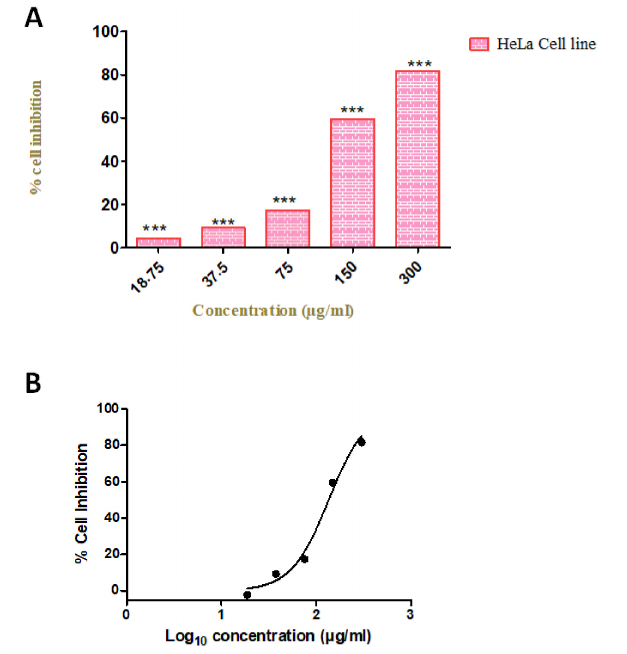
Figure 7. Cellular metabolic activity indicated by cell viability. ( A ) Cytotoxicity assays of Azima tetracantha compound treated for 24 h in HeLa cell lines. The symbol (***) indicate the significant difference ( p < 0.001). ( B ) Percentage cell inhibition of Log 10 concentration ( µ g/mL) on HeLa cell lines.